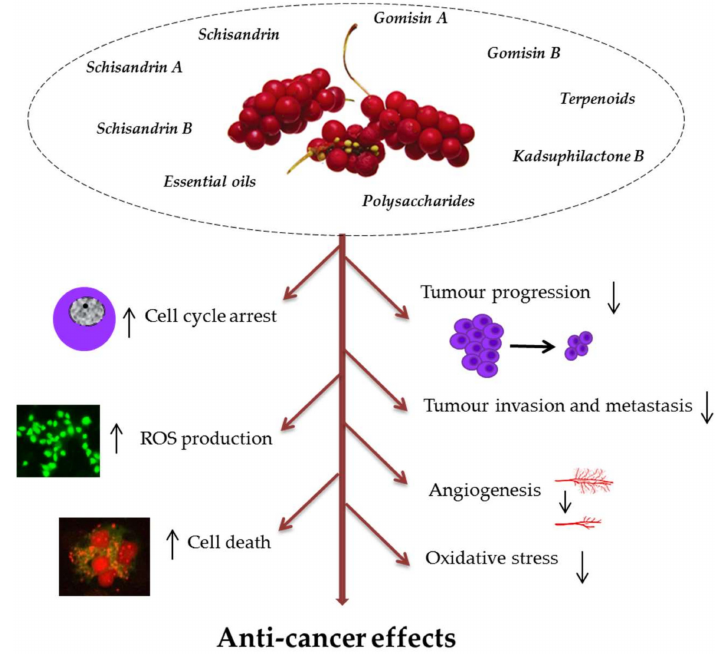
Figure 1. Mechanisms of anti-cancer activity of bioactive phytochemicals in Schisandra chinensis (SCE). They may inhibit tumour progression through cell cycle arrest at G0/G1 and G2/M, suppression of proliferation, invasion, metastasis, and angiogenesis. SCE antioxidative action includes induction of the antioxidant enzymes and direct scavenging of reactive oxygen species (ROS) to prevent cancer induction and progression. Their pro-oxidant effects lead to increased ROS production in cancer cells and cell death (apoptotic and